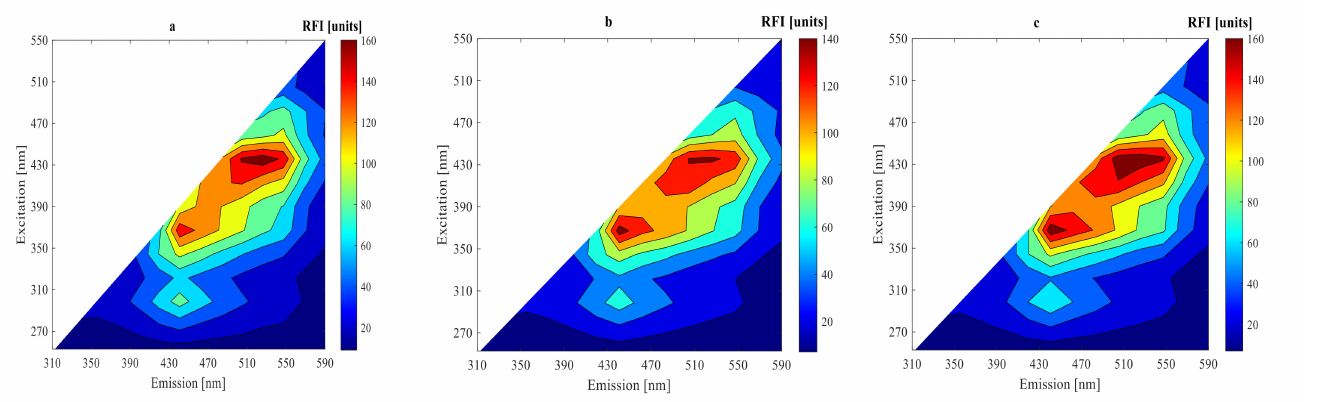
Figure 4. Original spectra after ( a ) 0 h, ( b ) 9 h, and ( c ) 15 h fermentation of 4 g/100 mL substrate inoculated with 6 log cfu/mL mixed strains of Lactiplantibacillus plantarum A6 and Lacticaseibacillus rhamnosus